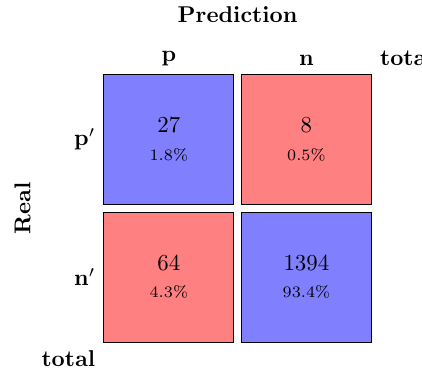
Figure 4. Confusion matrix—thresholds.